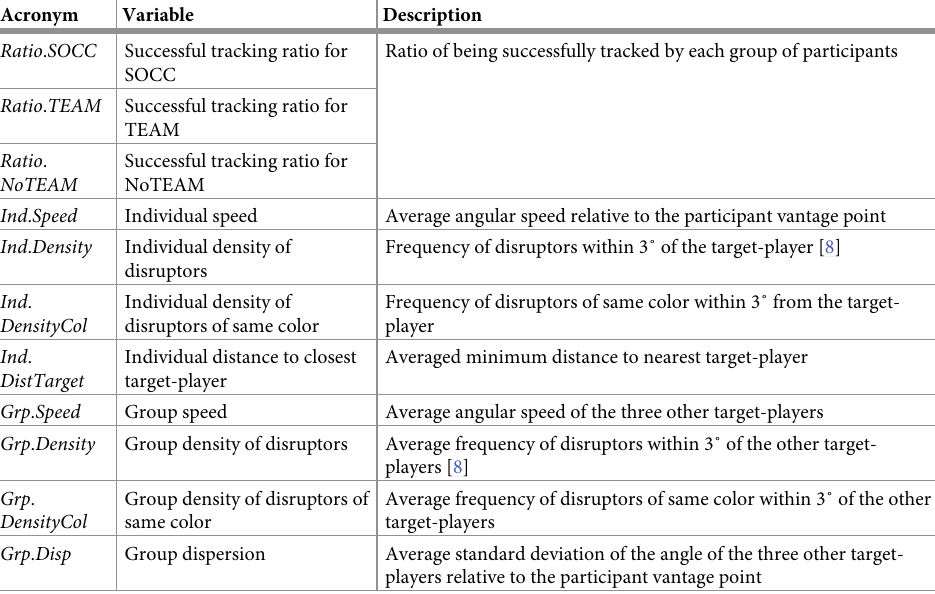
Table 1. Description of investigated features in the exploratory